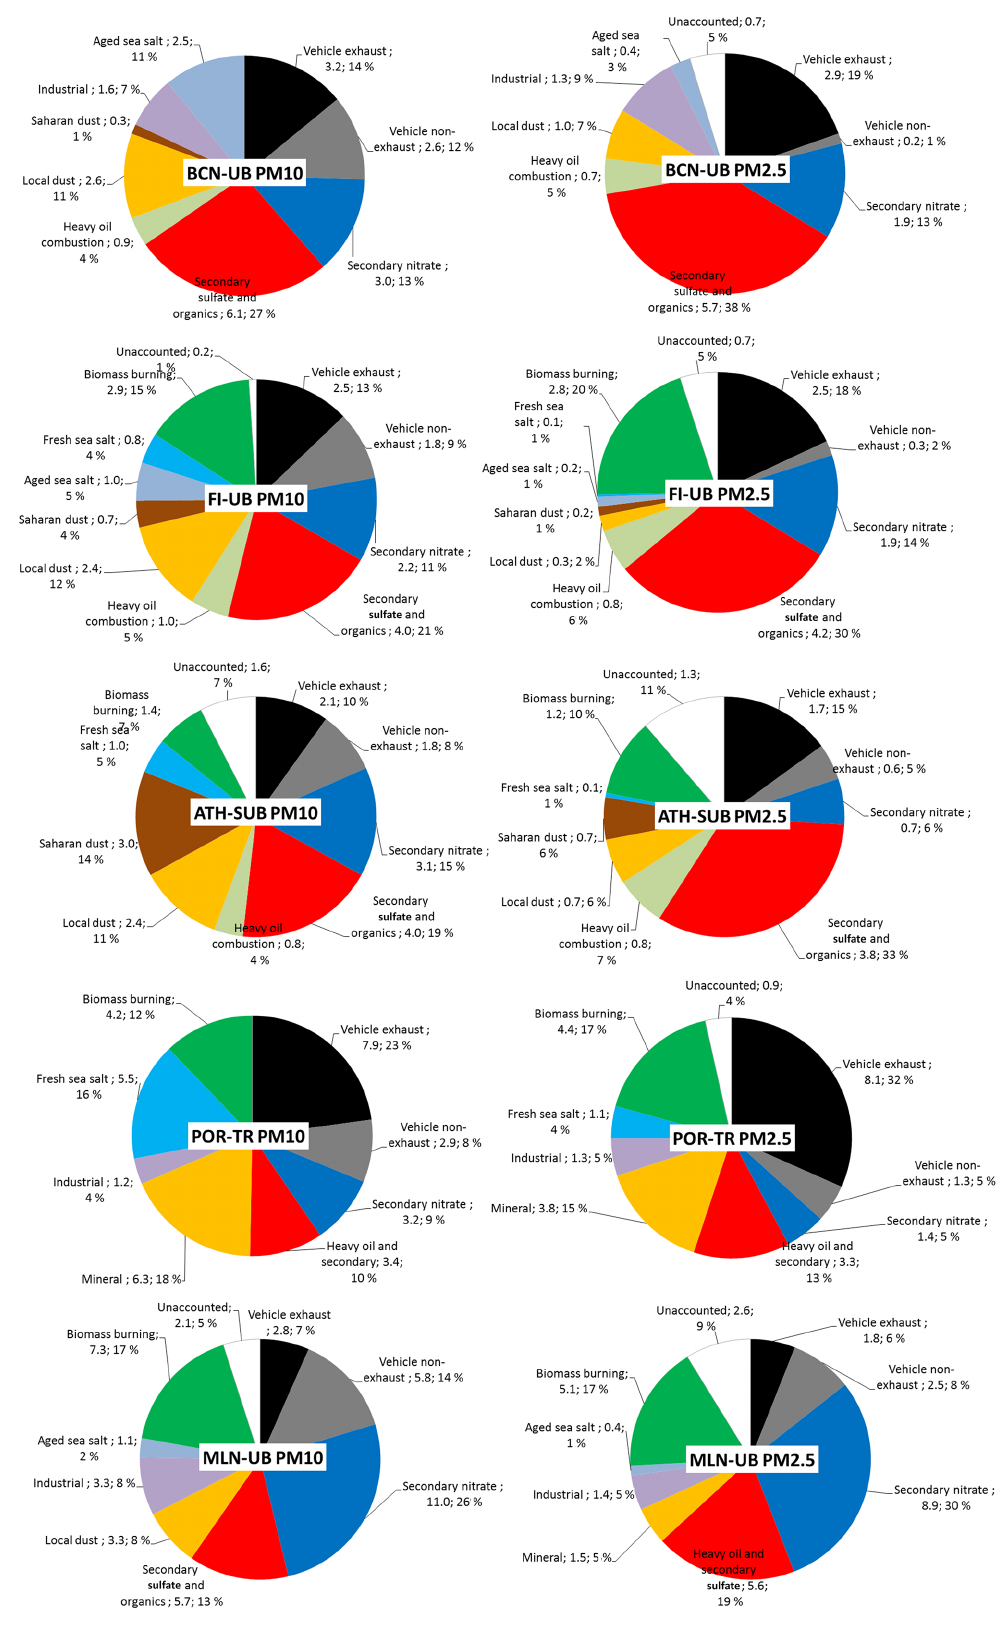
Figure 5. Average contribution (%) of PM 10 and PM 2 . 5 sources for 12 months of